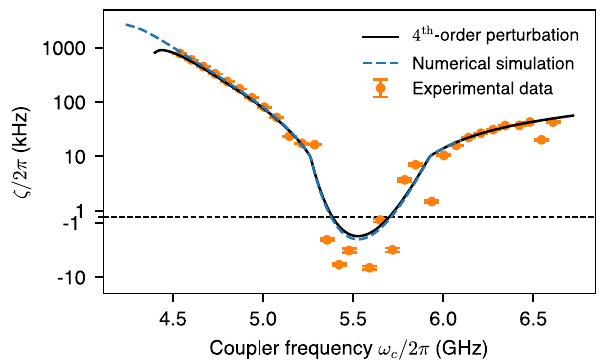
FIG. 14. Static ZZ interaction strength ζ as a function of the coupler frequency ω . QB1 and QB2 are biased at ω 1 = 2 π ¼ c 4 . 16 GHz and ω 2 π ¼ 4 . 00 GHz. The solid black curve cor- 2 = responds to ζ obtained by the perturbation theory up to the fourth order without rotating-wave approximation [Eq. (E3)]. The blue dashed curve corresponds to ζ obtained by numerically diagonal- izing the system Hamiltonian [Eq. (1); see Appendix Q for the parameters